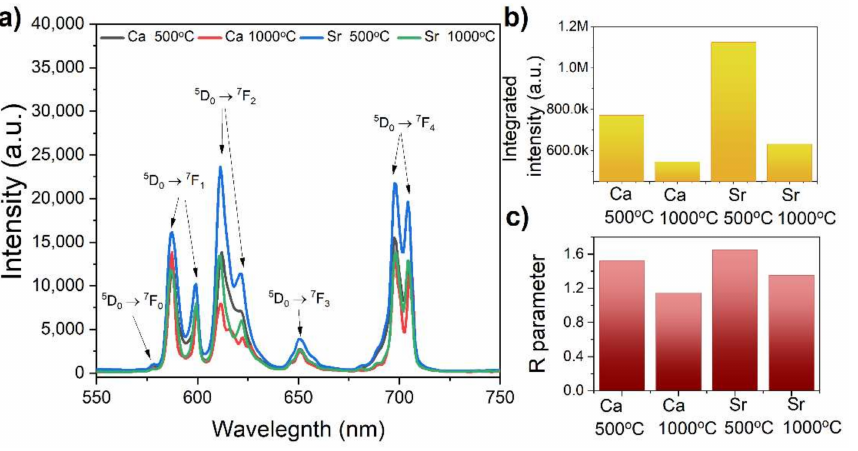
Figure 9. ( a ) The emission spectra of K Me Y(PO 4 ) 2 :5% Eu 3+ , λ exc = 393 nm, ( b ) the integrated intensity of registered emissions, and ( c ) the R parameter of investigated